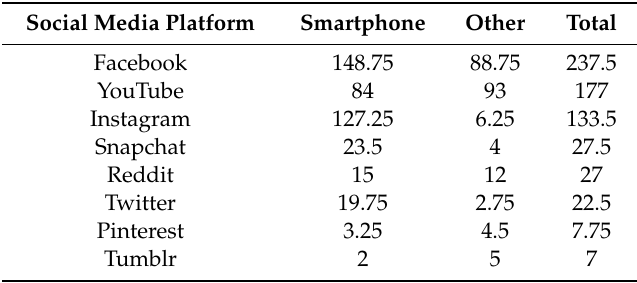
Table 1. Social media weekly use hours before abstinence across smartphones and other digital devices (i.e., desktop, tablet, and television; N =